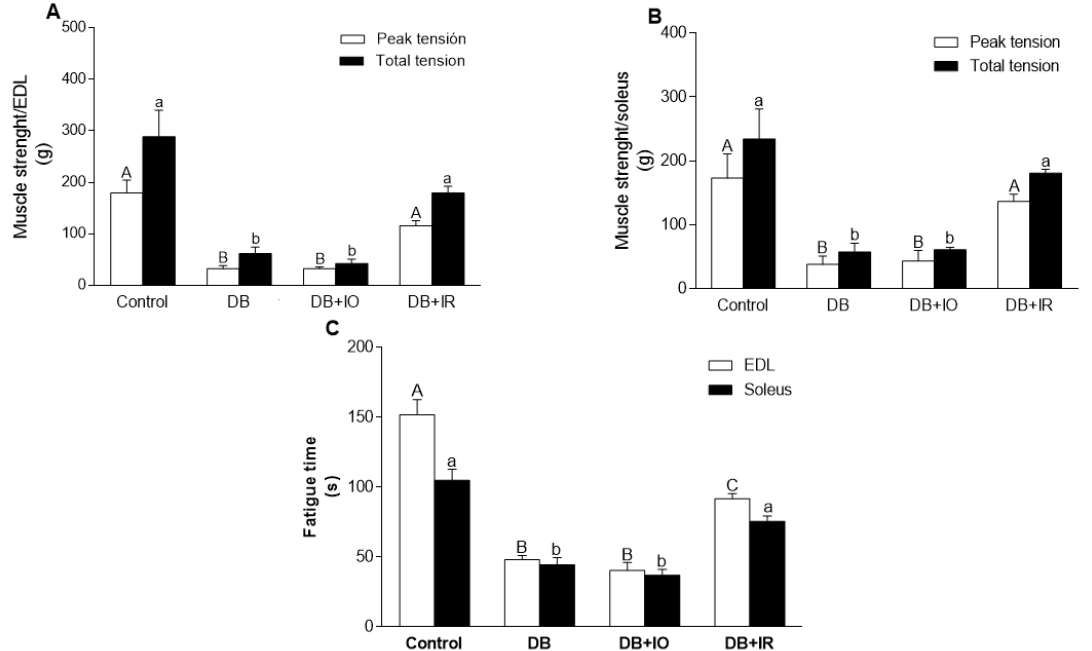
Figure 3. Effect of iron on muscle strength development in EDL ( A ), soleus muscle ( B ) peak tension (open bars) and solid bars (total tension). Effect of iron on fatigue ( C ) in EDL (open bars) and soleus muscles (solid bars). Data are presented as group mean ± standard error. p < 0.05 ( n = 6, ANOVA plus Tukey’s post hoc test). ( A – C ) represent the statistically significant differences between the different groups of the peak tension (open bars); a, b represent the statistically significant difference between the different groups of the total tension (solid bars); DB + IO, diabetic rats with iron overload; DB + IR, diabetic rats with iron restriction diet.